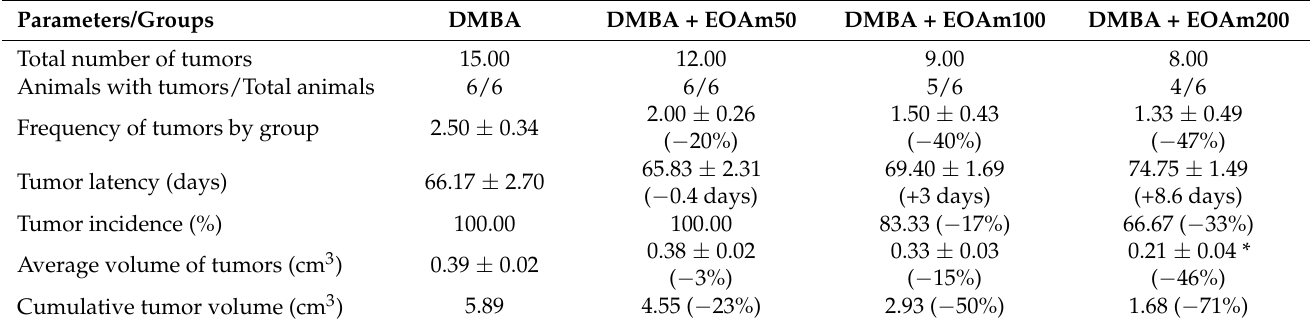
Table 2. Histological findings in female rats treated with the essential oil from A. muricata leaves.